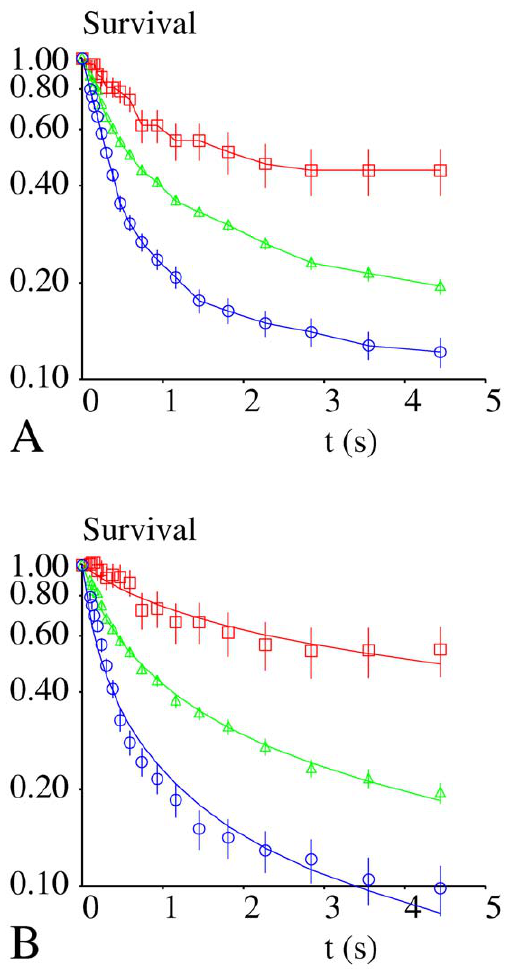
Figure 3. Lifetime of binding events recorded on surfaces coated with monovalent ICAM-1. The figure shows the survival curves of binding events recorded between surfaces coated with low densities of monovalent ICAM-1 and microspheres coated with anti- ICAM-1 antibodies. Red, squares: wall shear rate 9.3 s 2 1 , microsphere velocity 11.25 m m/s, 47 binding events recorded. Green, triangles: wall shear rate 18.5 s 2 1 , microsphere velocity 22.5 m m/s, 1,725 binding events recorded. Blue, circles: wall shear rate 29.4 s 2 1 , microsphere velocity 35.7 m m/s, 936 binding events recorded. Fig. 3A : the raw values were used. Fig. 3B : values were corrected to account for nonspecific events as explained. The curves represented the best fits of experimental curves with Eq. 2. Squares: Force on bond is 8.37 pN, k(F,0)=0.441 s 2 1 , a(F)=1.099 s 2 1 , red line: calculated fit, MSD=3.7 10 2 3 . Crosses: Force on bond is 16.75 pN, k(F,0)=1.735 s 2 1 , green line: calculated fit, MSD=0.99 10 2 3 . Circles: Force on bond is 26.61 pN, k(F,0)=4.603 s 2 1 , a(F)=6.149 s 2 1 , MSD=12.4 10 2 3 . Vertical bar length is twice standard error.